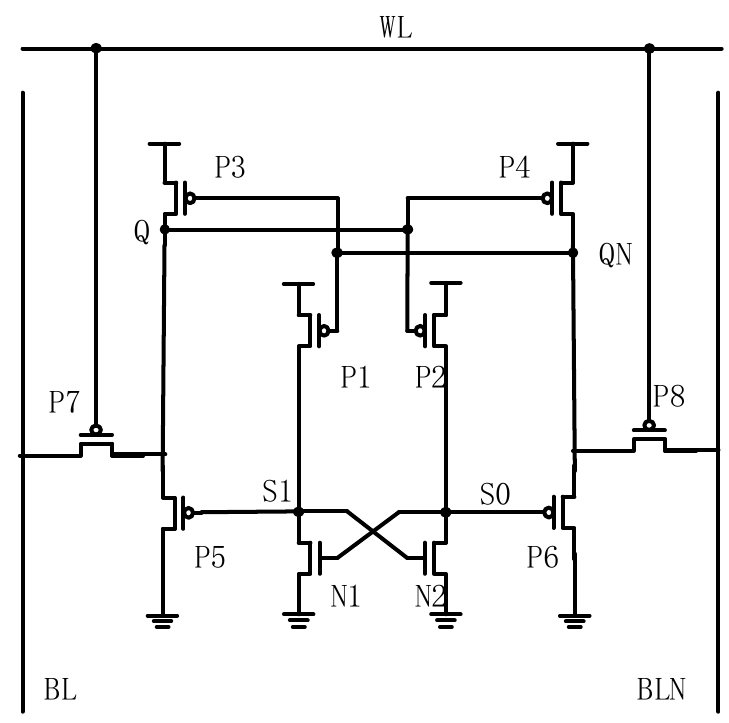
Figure 1. Schematic of the proposed PP10T SRAM cell.